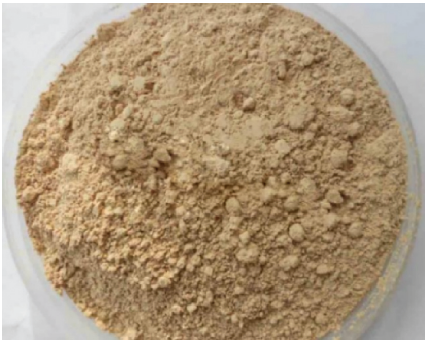
Figure 1: The physical appearance of